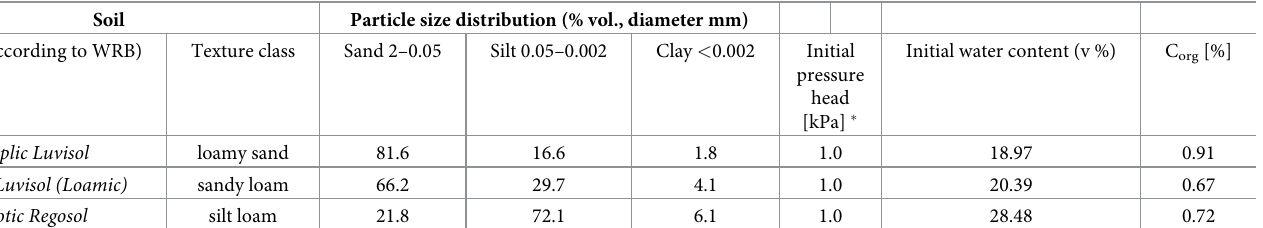
Table 1. Characteristics of soil materials.